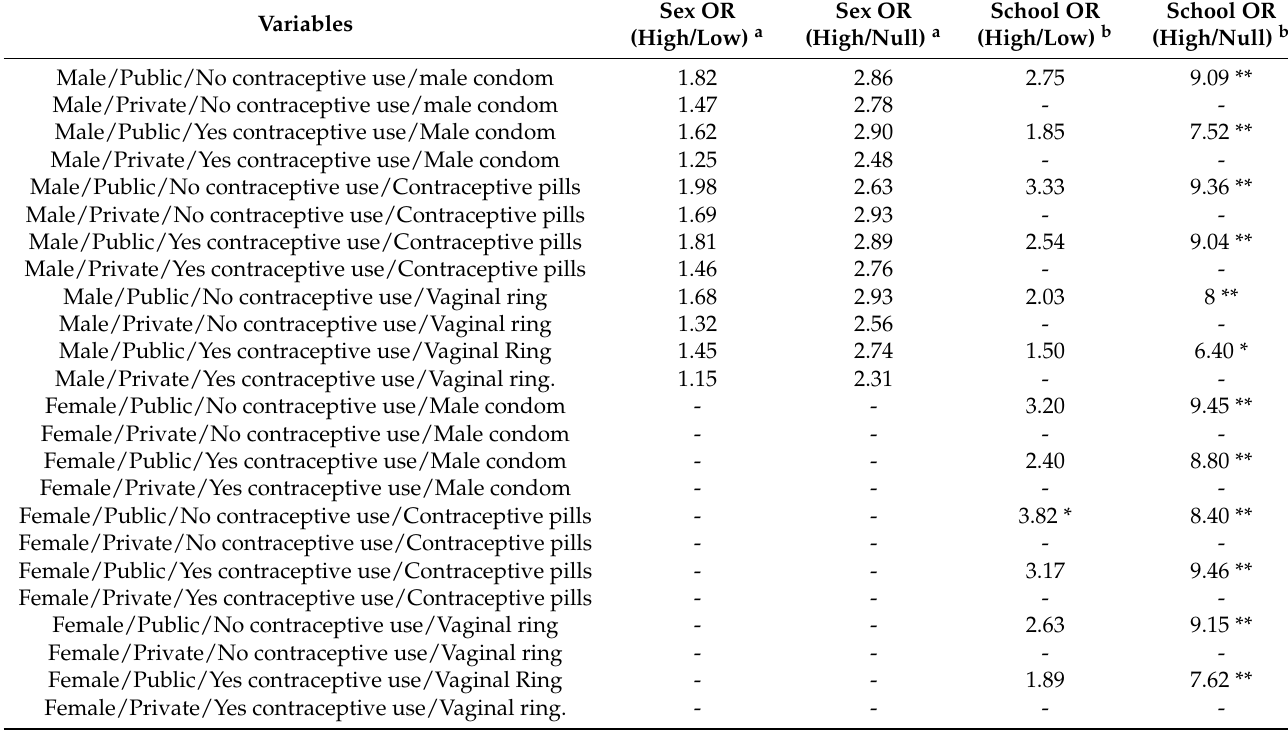
Table 4. Estimated odds ratio for the sex and college